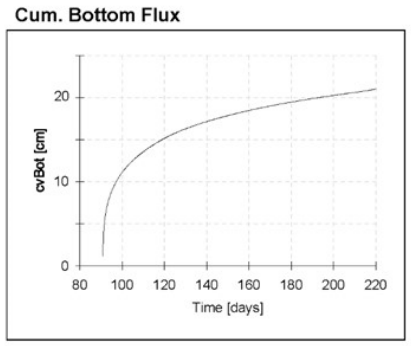
Figure 5. Cumulative capillary rise curve for corn cultivation.